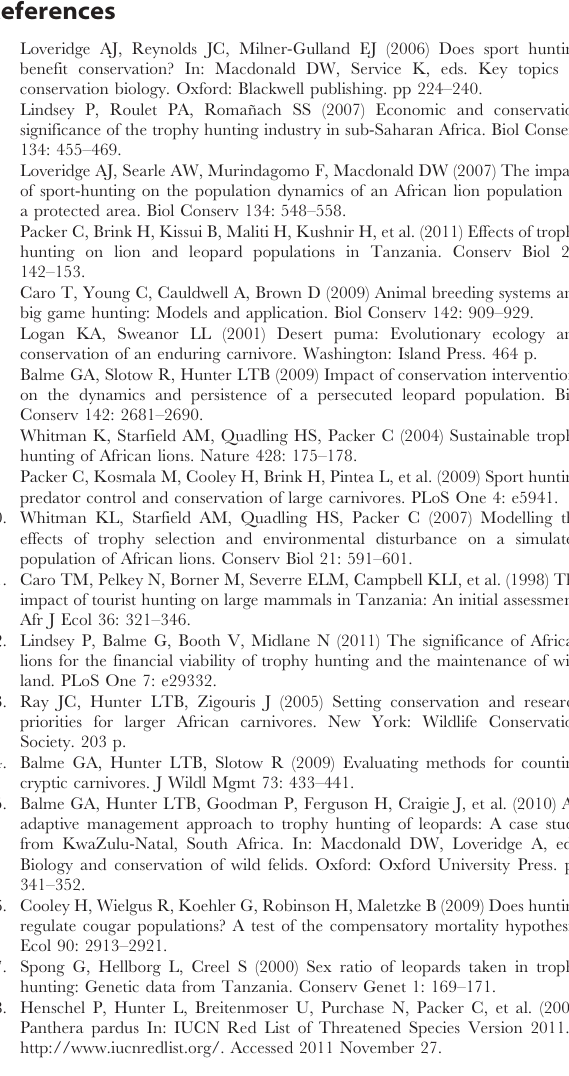
Figure S4 Examples of leopard trophies from different countries exhibited on hunting company websites that are likely females or , 2 year males. (A) Botswana; (B) Mozambique; (C) Namibia; (D) Tanzania; (E) Zambia; (F) Zimbabwe. (TIF) Figure S5 Protocol for collecting data from trophy hunted lion and leopard. (TIF) Table S1 Results of generalized linear models assessing the likelihood of professional hunters correctly identi- fying the sex of leopards in survey photographs. (DOC) Table S2 Results of generalized linear models assessing the likelihood of professional hunters assigning photo- graphs of male leopards to their correct age class. (DOC) Table S3 Morphological measurements of radio-col- lared leopards from the Phinda-Mkhuze Complex (PMC) in northern KwaZulu-Natal, South Africa [ 19 ] .